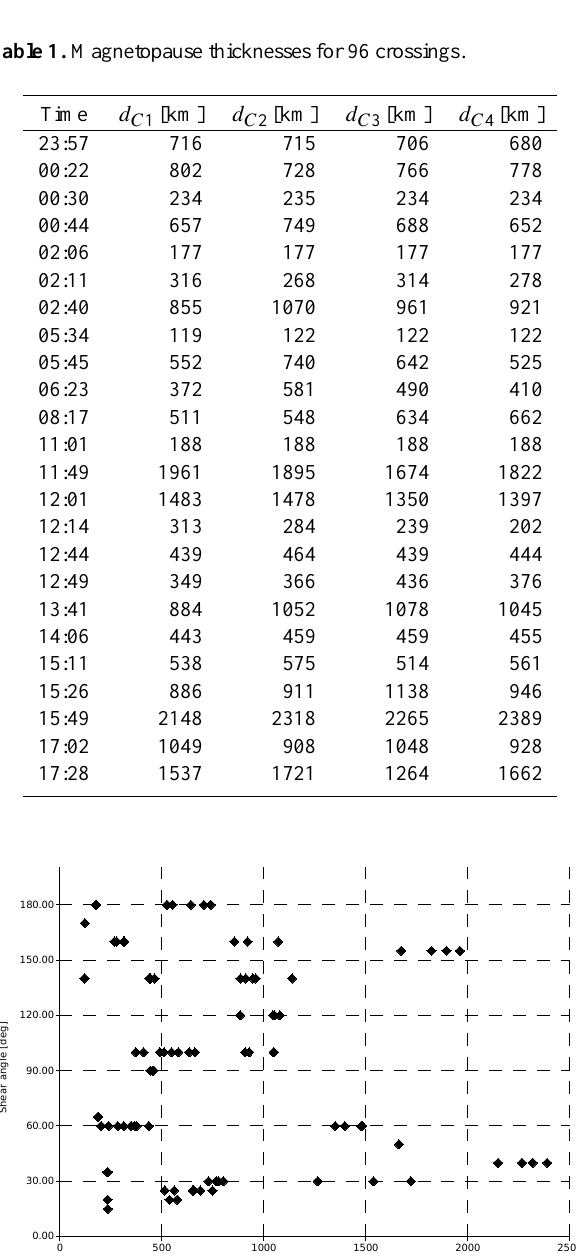
Fig. 11. Magnetic shear plotted versus magnetopause thickness for the 96